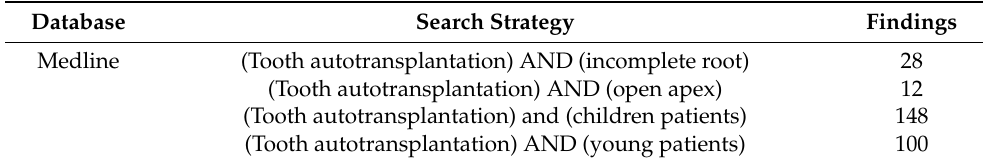
Table 1. Search strategy and